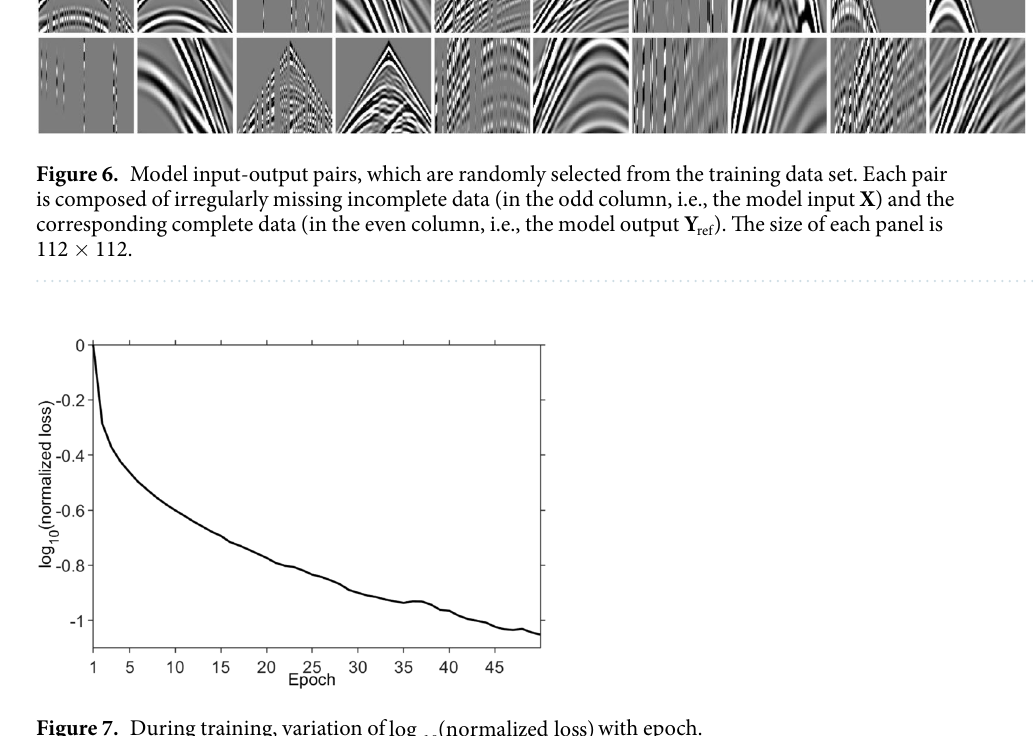
Figure 7. During training, variation of log (normalized loss)